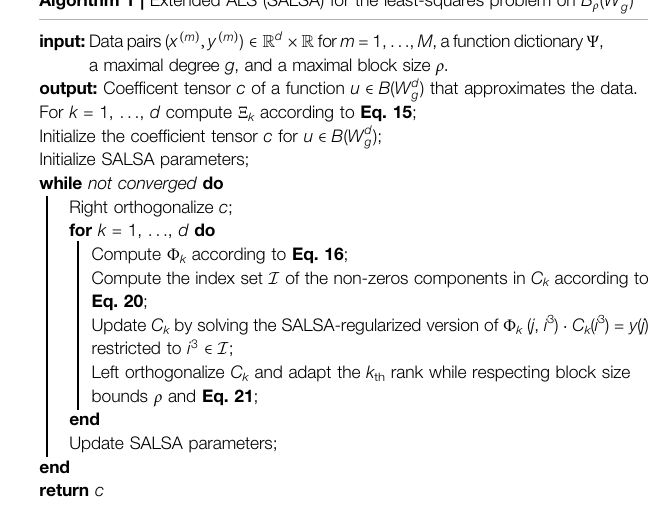
Algorithm 1 | Extended ALS (SALSA) for the least-squares problem on B ρ ( W d g